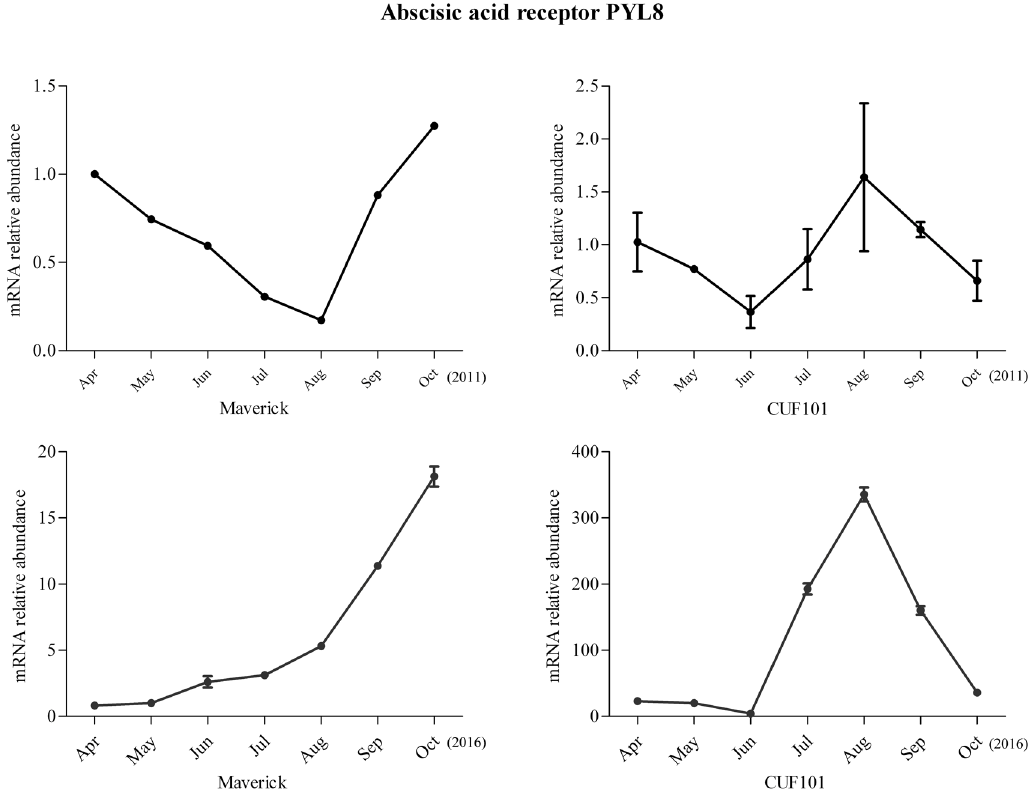
Fig 6. mRNA abundance of the abscisic acid receptor PYL8 in Maverickand CUF101varietiesfrom April to October in 2011 and 2016. ** indicatessignificantdifference betweenSeptember-October and August at p < 0.01.